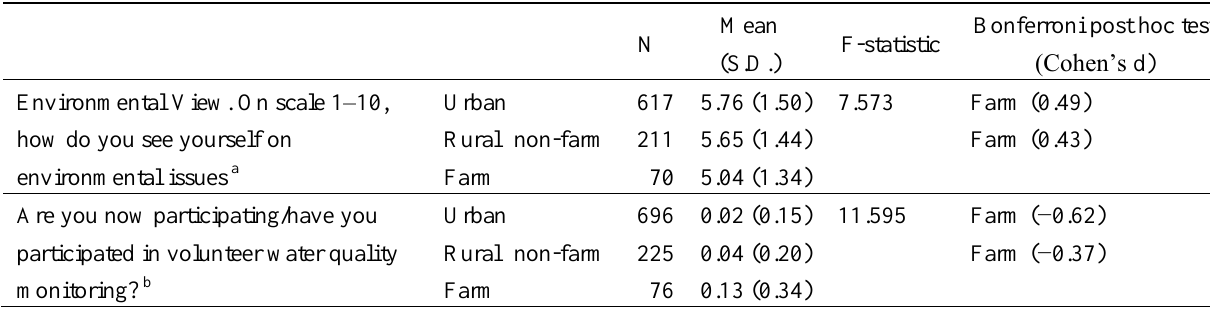
Table 5. Comparison of differences in environmental views and actions among urban, rural non-farm and